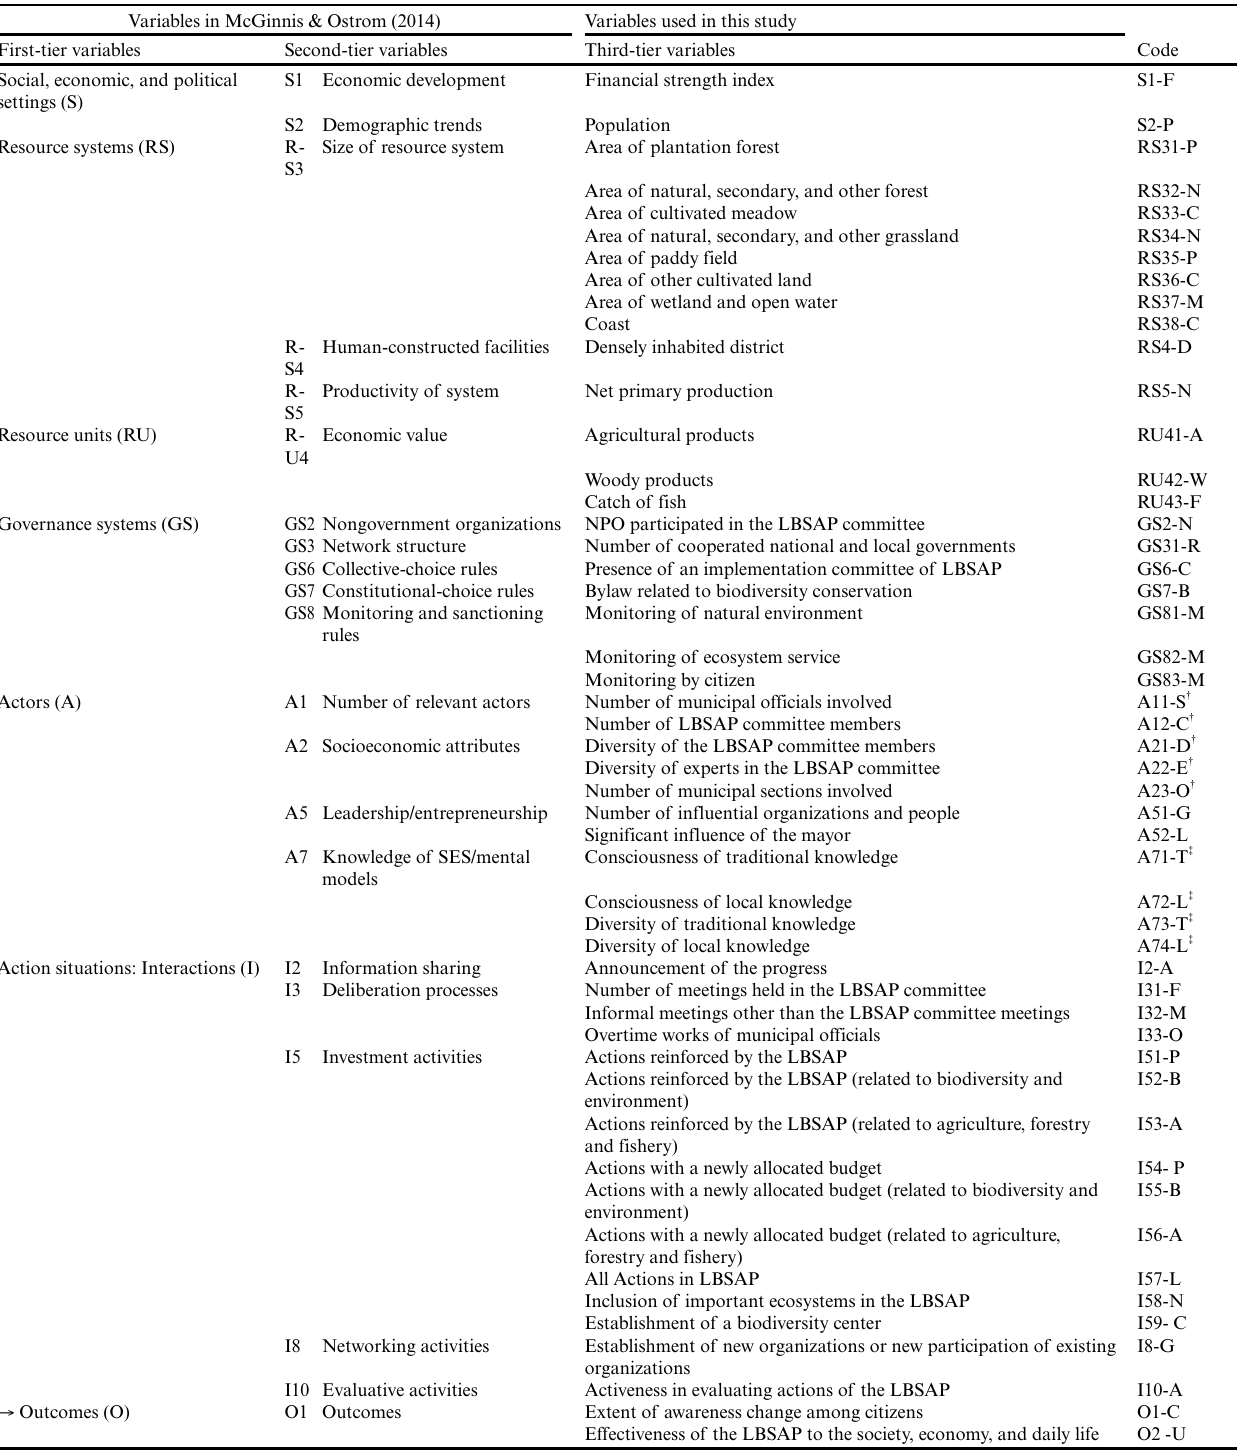
Table 1 . Variables of the social-ecological system framework used in this study according to McGinnis and Ostrom